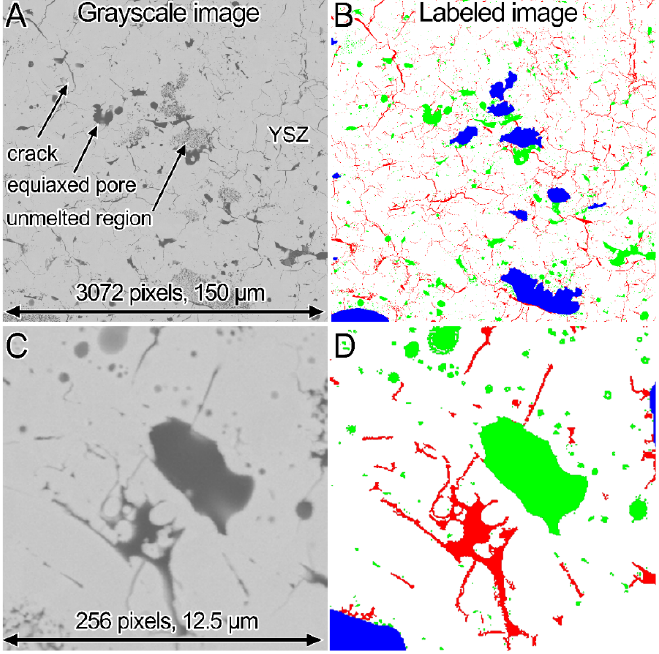
Figure 3. ( A ) Initial grayscale SEM image, ( B ) manually labeled image, ( C ) cropped grayscale image used for training, and ( D ) manually labeled image of the image in ( C ). Cracks, equiaxed pores, unmelted regions, and YSZ are indicated by red, green, blue, and white, respectively.